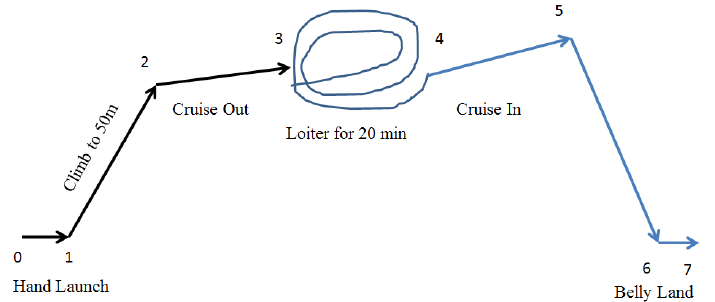
Figure 1. Mission profile consisting of hand launch, steady climb, steady cruise and steady descend mission